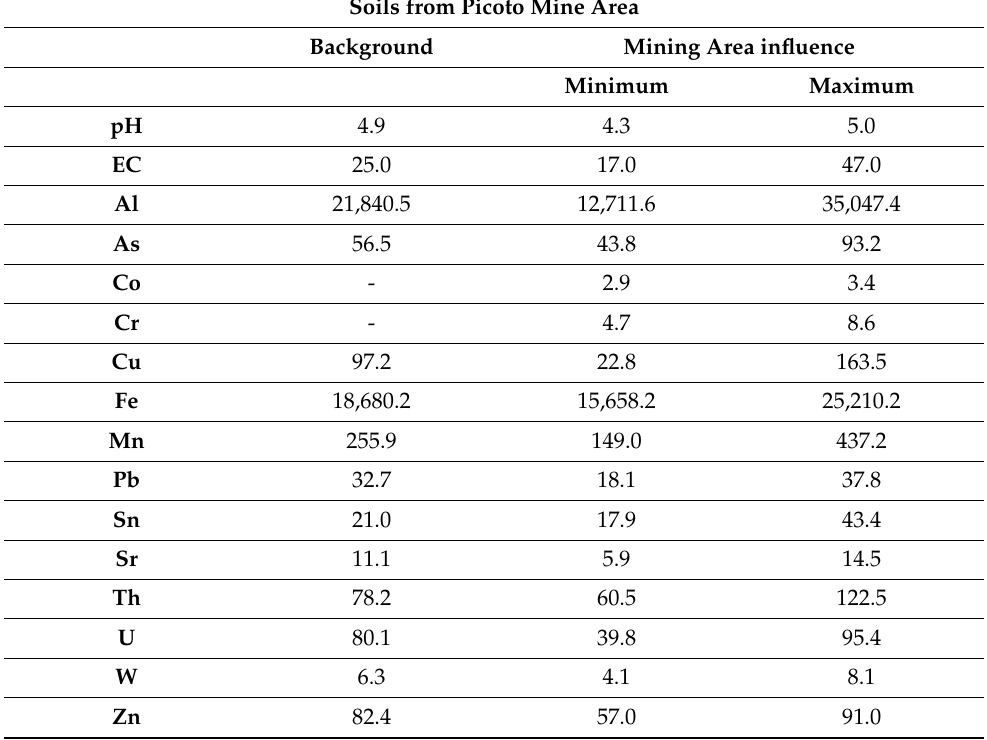
Table 2. Physical–chemical parameters and concentration of selected metals and As from soils of the Picoto mine